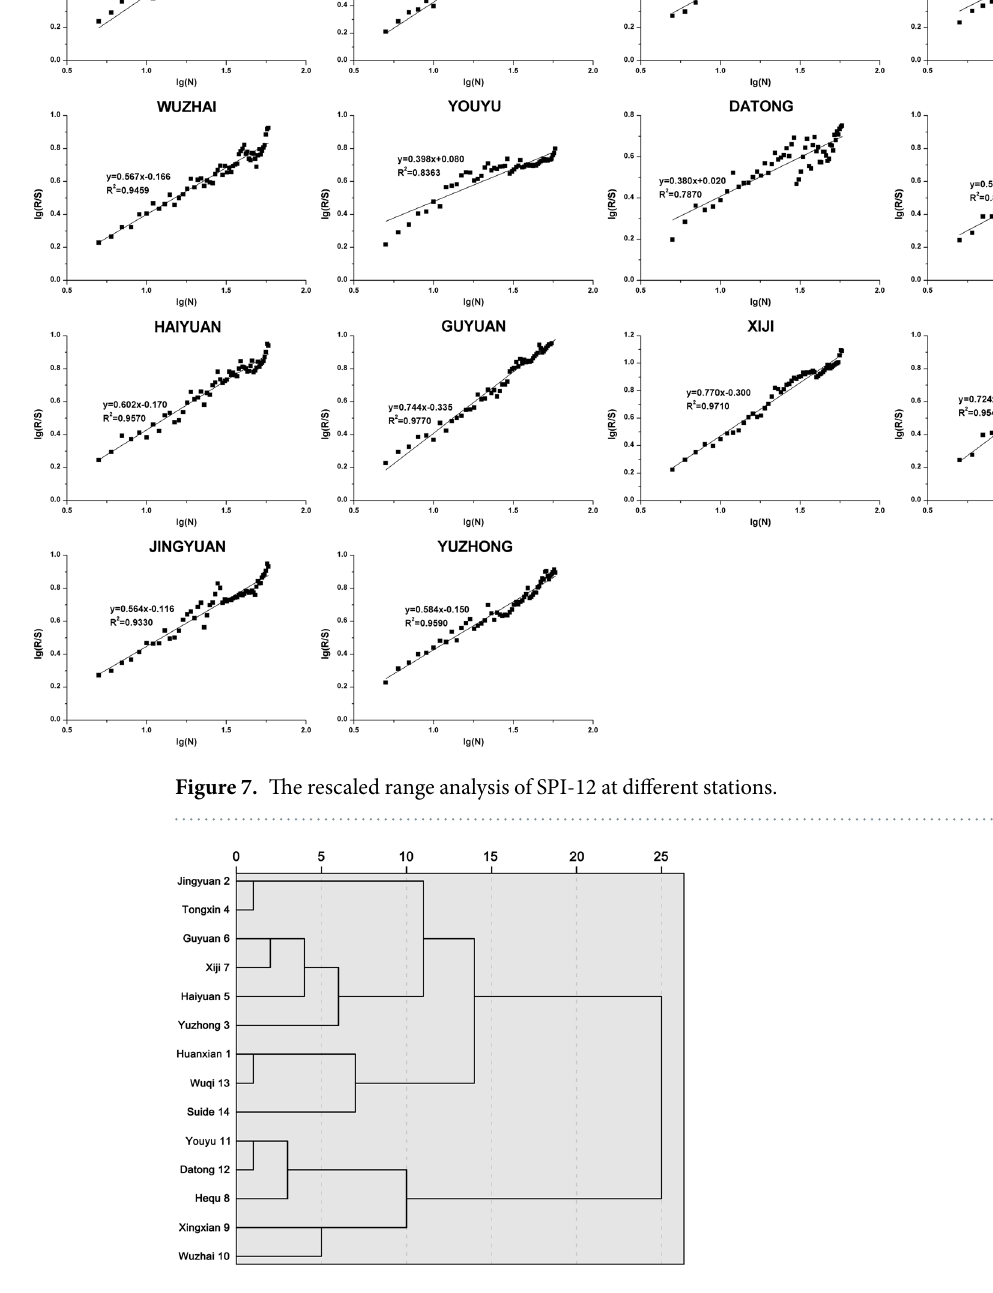
, if r 1 falls within the range calculated t